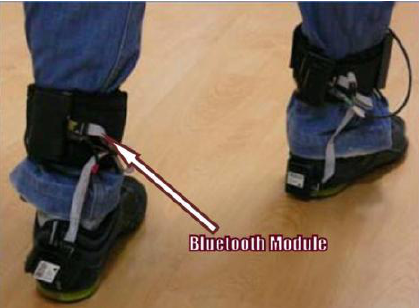
Figure 22. A wireless systems for gait and posture analysis based on pressure insoles and inertial measurement units